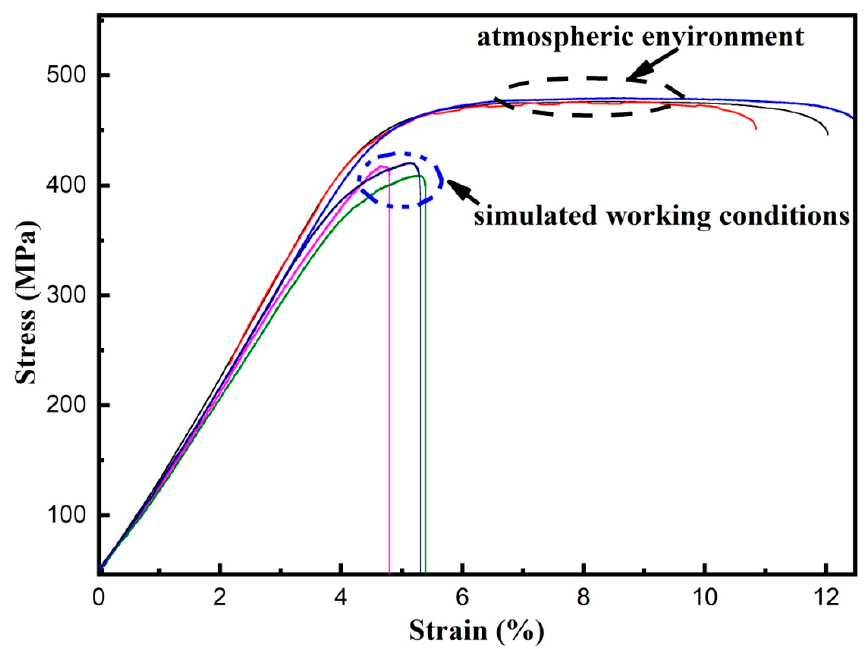
Figure 3. The stress-strain curves under different conditions. Table 2. The slow tensile test results of 7085 aluminum alloy in different